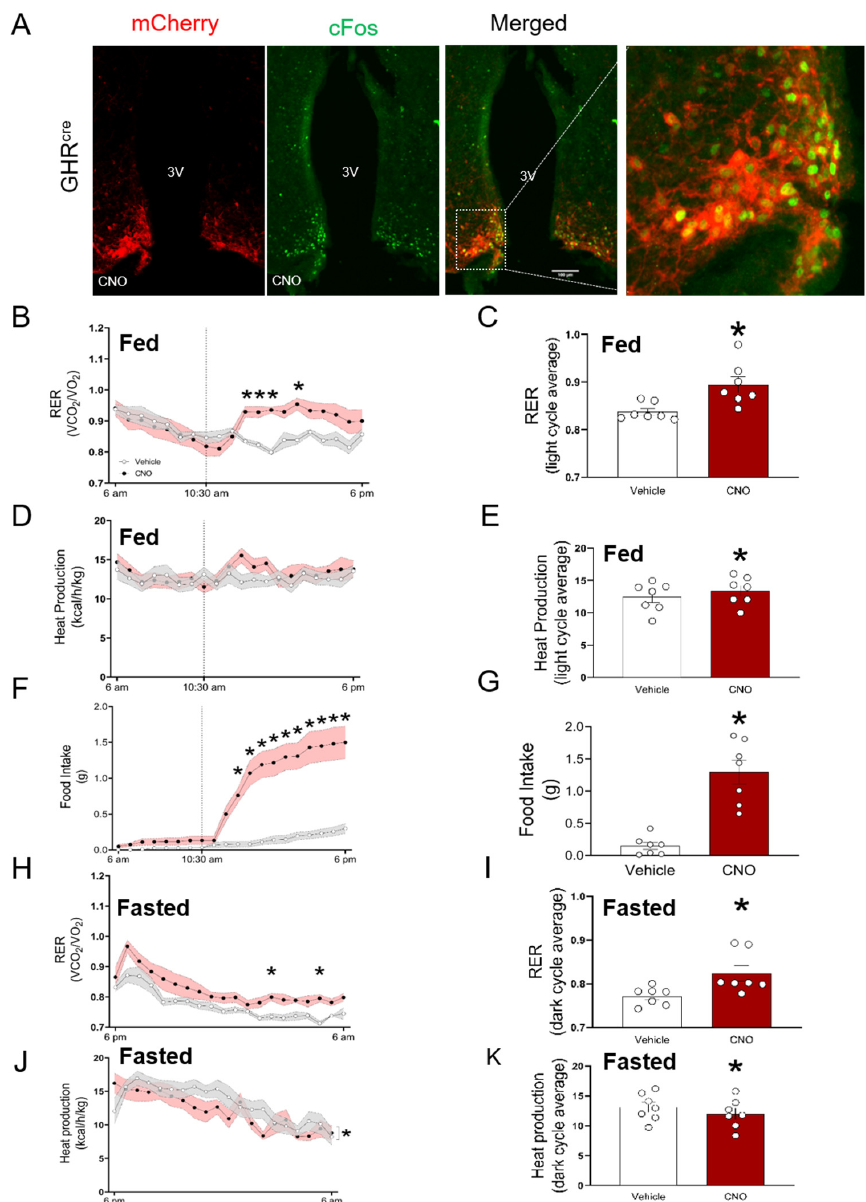
Figure 3. Acute activation of ARC GHR neurons alters the energy homeostasis in fed and fasted mice. ( A ) Neuronal activation by cFos (green) was assessed 1 h after clozapine n -oxide (CNO) stimulation. immunohistochemistry (IHC) for mCherry (red) identifies the AAV-hM3Dq expression in the ARC GHR+ neurons. The merged image and dashed box indicate the colocalization of cFos and mCherry. 3V—third ventricle. Scale bar: 100 µ m. Mice in metabolic chambers injected with saline (grey) or CNO (red) at 10:30 a.m. ( B ) Respiratory exchange ratio (RER) and ( C ) area under the curve (AUC) for the RER light cycle period. ( D ) Heat production and ( E ) AUC for heat production in the light cycle. ( F ) Food intake and ( G ) AUC of the light cycle period for food intake beginning at the treatment time. Mice in metabolic chambers were i.p. injected with either saline (grey) or CNO (red) at 5 pm, 1 h prior the start of the fasting period. ( H ) Respiratory exchange ratio (RER) and ( I ) AUC for RER dark cycle average. ( J ) Heat production and ( K ) AUC for heat production in the dark cycle. Data were analyzed by repeated measure two-way ANOVA followed by Tukey’s post-hoc; n = 7; * p < 0.05. See also Figure